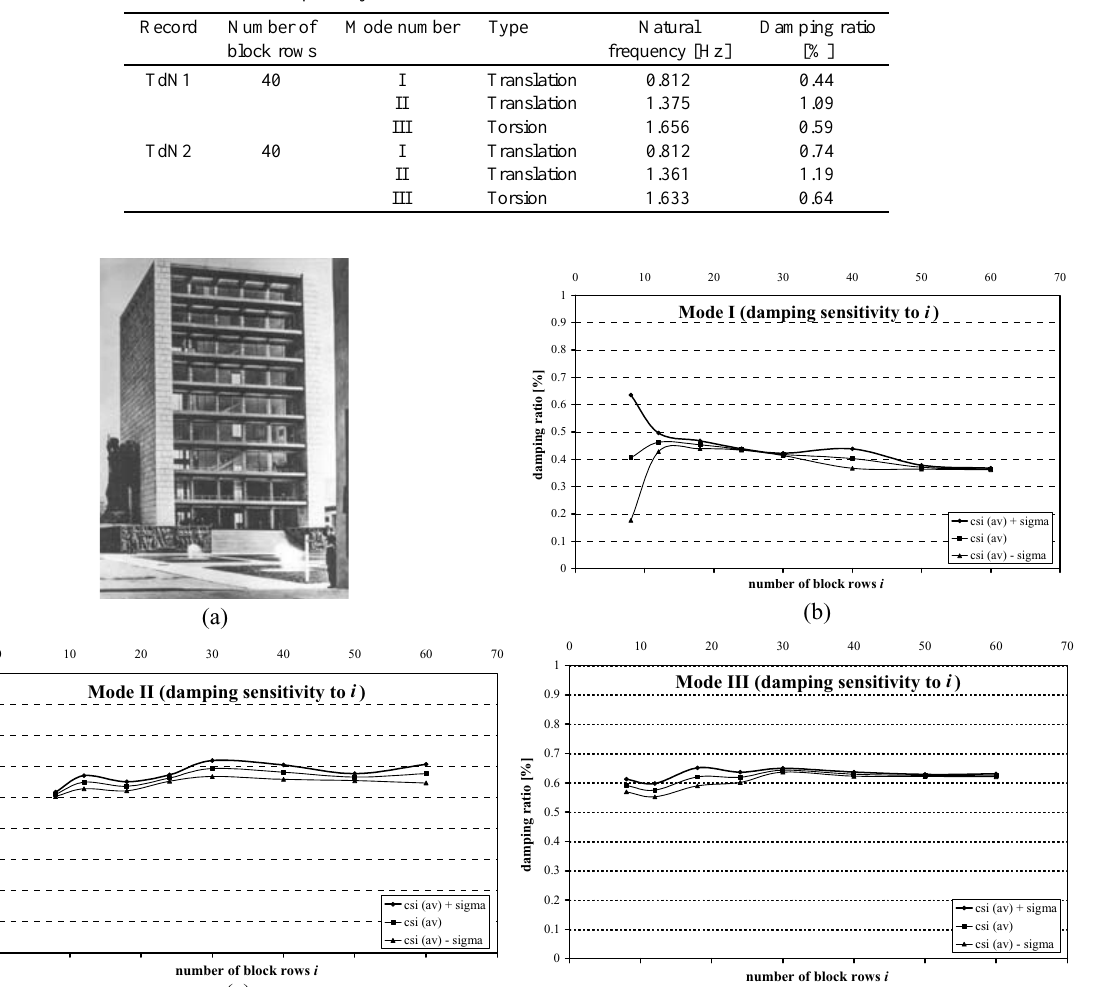
Table 4 Output-only modal identification results (Data Driven